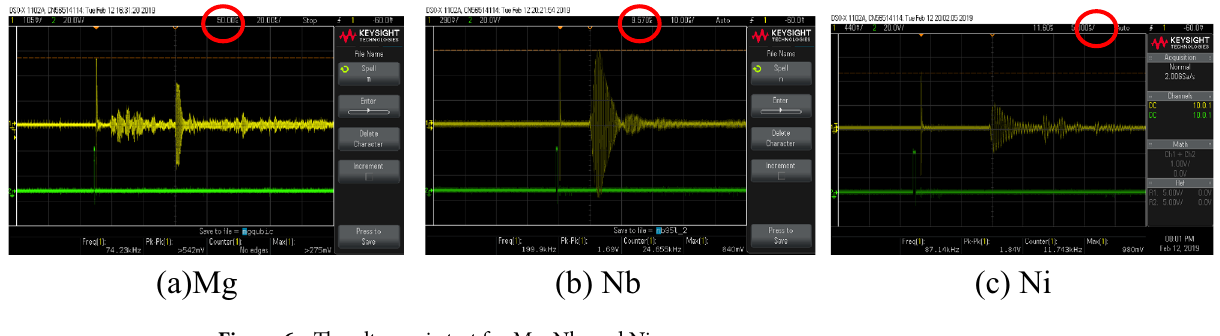
Figure 6. The ultrasonic test for Mg, Nb, and